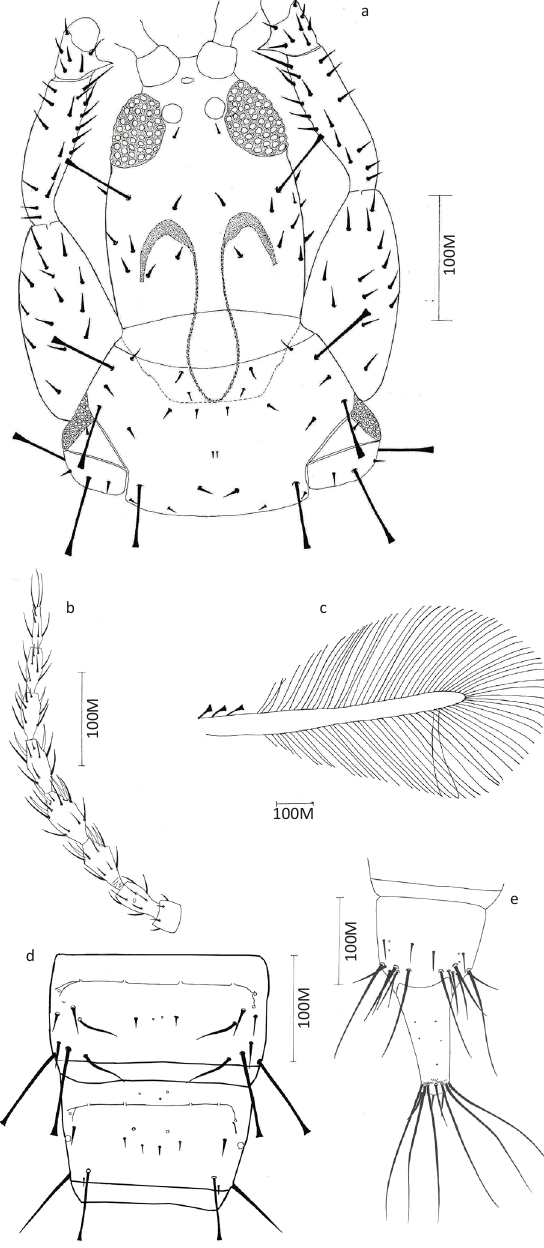
Figure 1. Tylothrips samirseni sp. nov. a - Head; b - Antenna; c - Forewing; d - VII & VIII abdominal segments; e - IX & X abdominal segments. ©